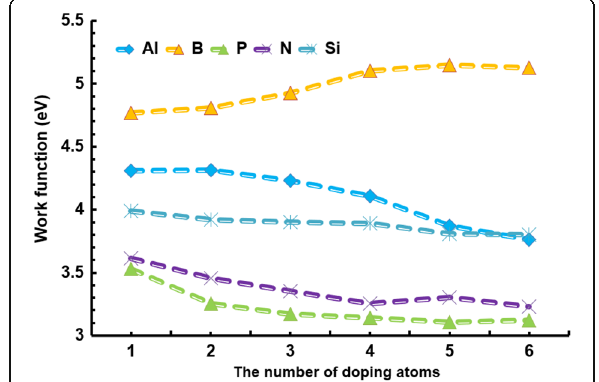
Fig. 5 The relationship between the formation energy and the number of doping atoms. The relationship between the formation energy and the number of doping atoms. Different types of doping atoms, e.g., Al, B, P, N, and Si, are doped in the graphene with 4×4-cell